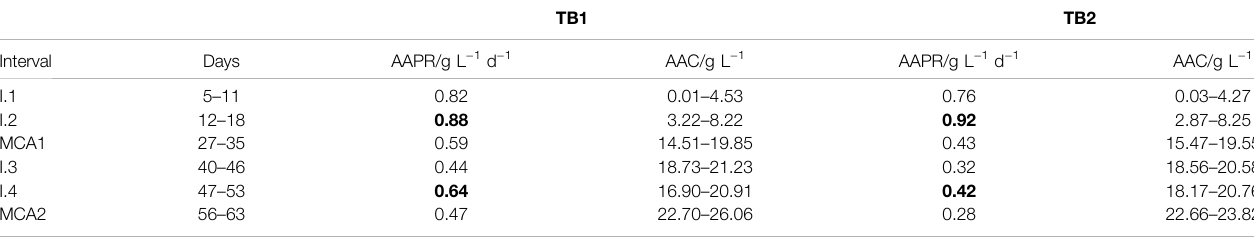
TABLE 2 | Calculated AAPRs over time intervals (I. and MCA) and corresponding AACs for TB1 and TB2.